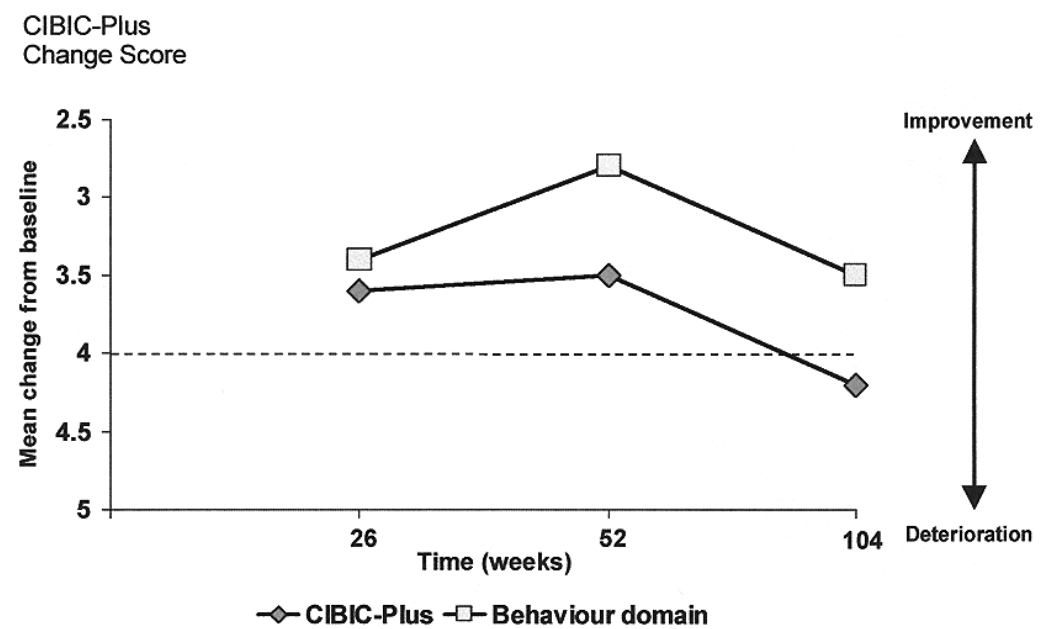
Fig. 1. Mean change from baseline in CIBIC-Plus and CIBIC-Plus behaviour domain rating during treatment with open-label rivastigmine (observed cases, n = 34). A score of 4 means unchanged symptoms, a score below 4 is indicating improvement and a score above 4 displays that the symptoms had worsened.